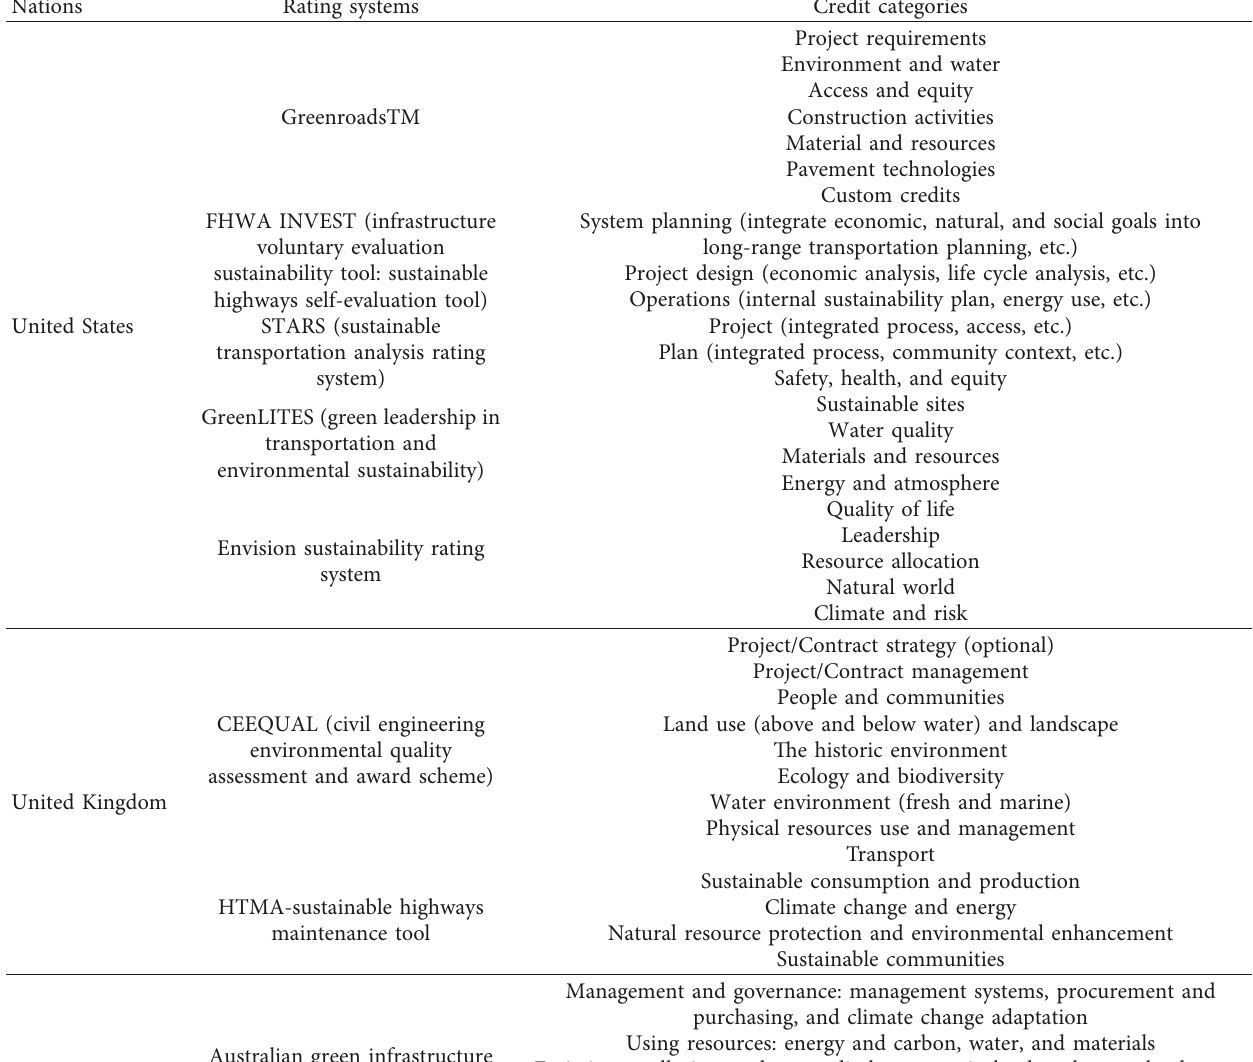
Table 1: The state of the practice in infrastructure sustainability